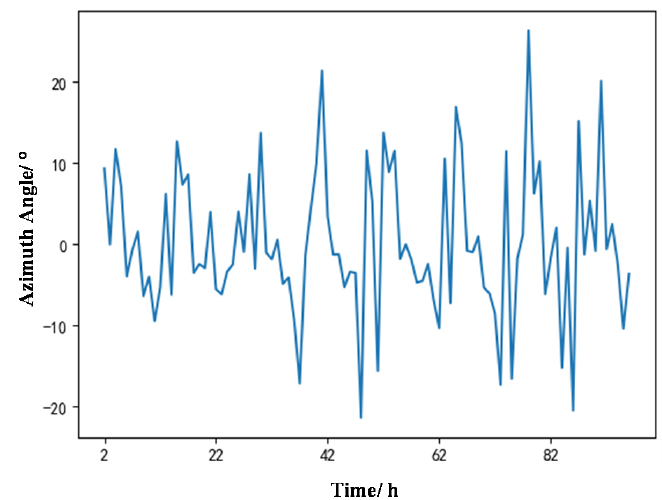
Figure 7. Offset distance trend.